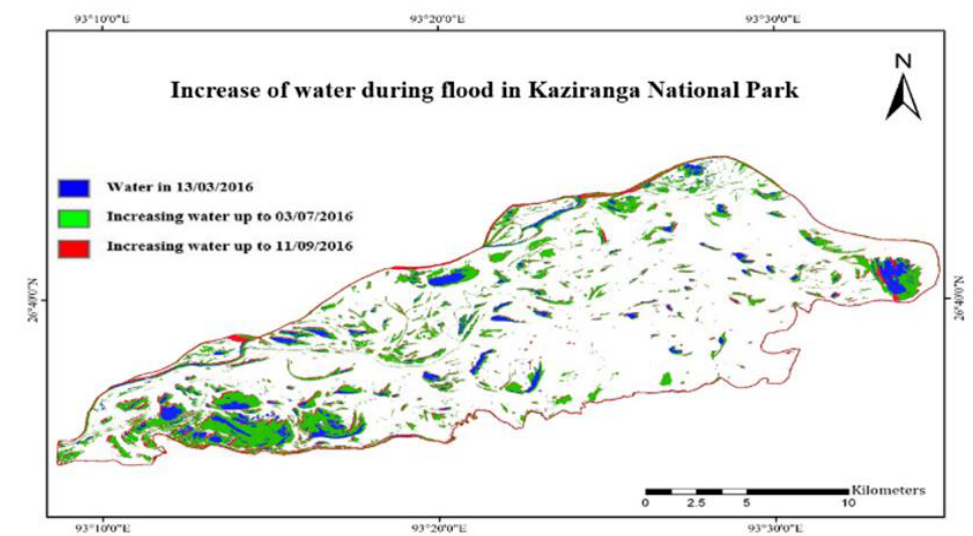
Figure 8. The increase of water during a flood in Kaziranga National